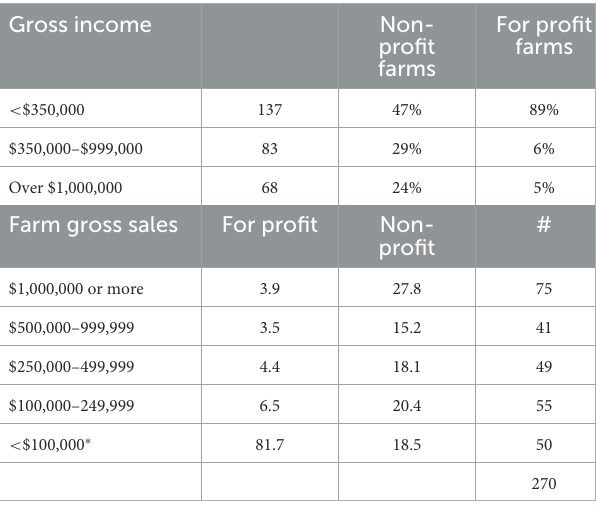
TABLE 2 Gross income, for profit (2021), and non-profit (2019–2021